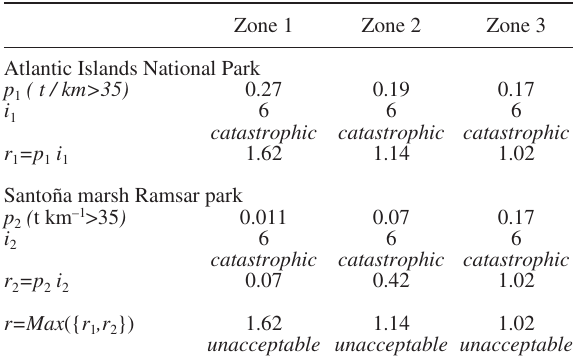
Table 5. – Estimation of the ecological risk for: (a) the Atlantic Islands National Park area and (b) the Santoña marsh Ramsar park